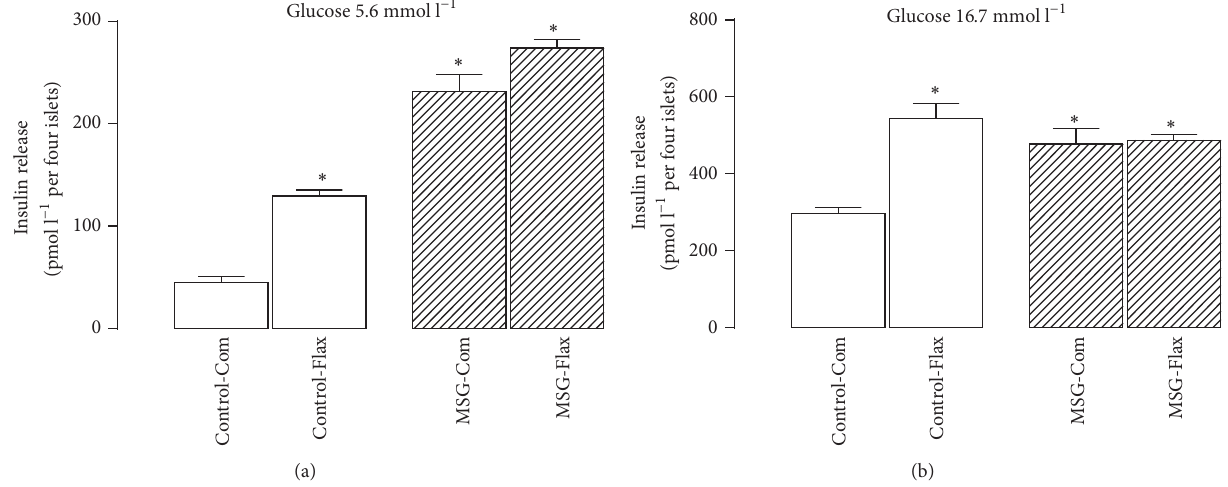
Figure 3: Effects of maternal flaxseed supplementation on insulin secretion stimulated by 5.6 mmoll −1 (a) or 16.7 mmoll −1 glucose (b). Bars represent the mean ± SEM of insulin secretion by pancreatic islets obtained from 8 mice of the 4 different litters ( 𝑛 = 4 ). The letters over the bars represent significant differences among the groups based on one-way ANOVA, where ∗ depicts statistical difference with 𝑃 < 0.05 compared to Control-Com